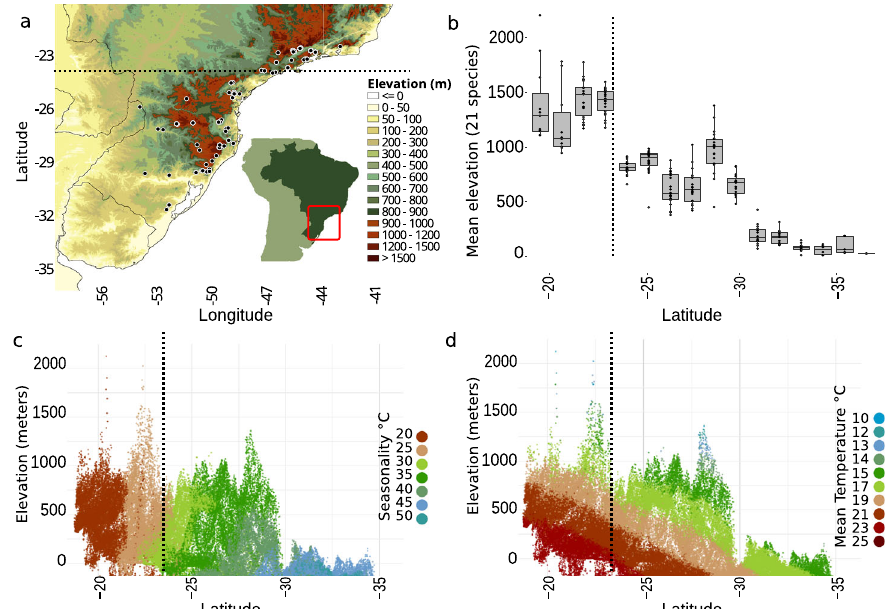
Fig. 1 Progressively lower elevational distributions of birds follow higher seasonality and lower mean temperatures towards the higher latitudes of the Atlantic Forest sky islands. a Sampling localities (black dots) in southern Atlantic Forest of 21 species of birds showing the elevation pro fi le of the region in meters (m; Geospatial Information Authority of Japan); b Boxplot for the elevation distribution of 21 species of birds showing the community-wide progressive occupation of lower elevations in higher latitudes ( n = 13,986 occurrence records average across species; mean = 608.1 and SD = 371.3 per species). Source data is provided in Supplementary Data 3. The boxplot is composed by the median (center), the fi rst and third quartiles (lower and upper hinges), and the 1.5 * IQR from the hinge (where IQR is the interquartile range; upper and lower whiskers); c Atlantic Forest elevational pro fi le based on the minimum convex polygon buffered by half latitudinal degree around the occurrence sites, showing the progressive increase in seasonality (annual range in temperature) towards higher latitudes; d Atlantic Forest elevational pro fi le showing the elevational distribution of mean temperature values across latitude. The dashed line represents the Tropic of Capricorn and indicates the transition between tropical (latitudes <23.5°) and subtropical (latitudes >23.5°) mountain regions.